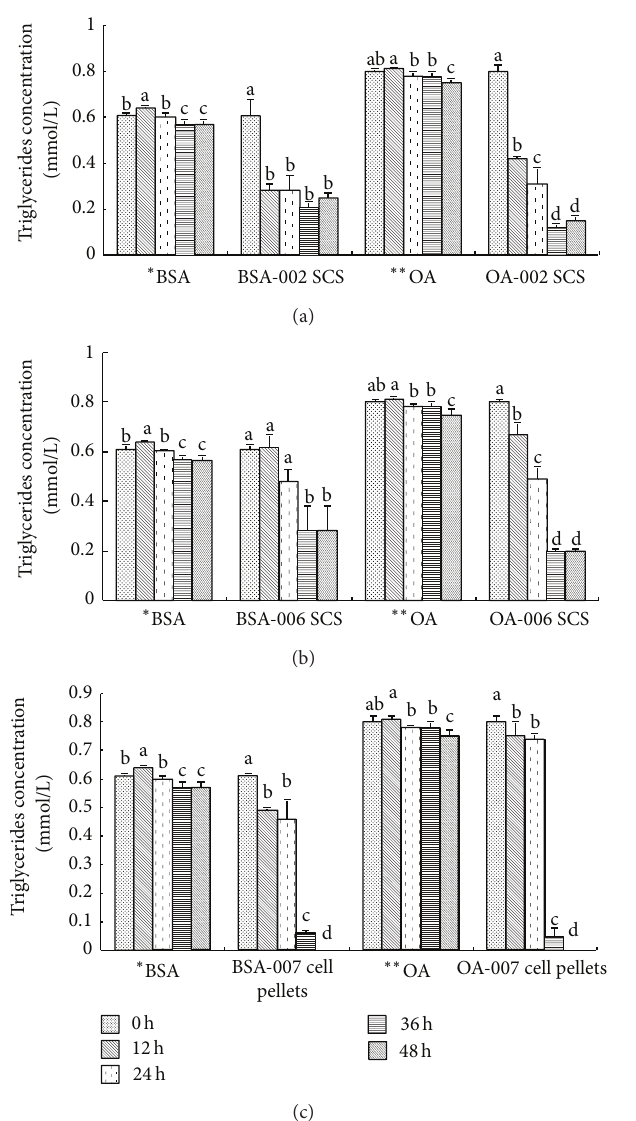
Figure 4: Inhibition of triglycerides in HepG2 cells treated with the spent culture supernatants (SCS) of LAB strains (a) NBHK002, (b) NBHK006, and (c) NBHK007. a , b , c , d Means with different superscript letters within the same culture are significant differences ( 𝑃 < 0.05 ) by Duncan’s multiple range test. ∗ BSA: bovine serum albumin; ∗∗ OA: oleic acid.